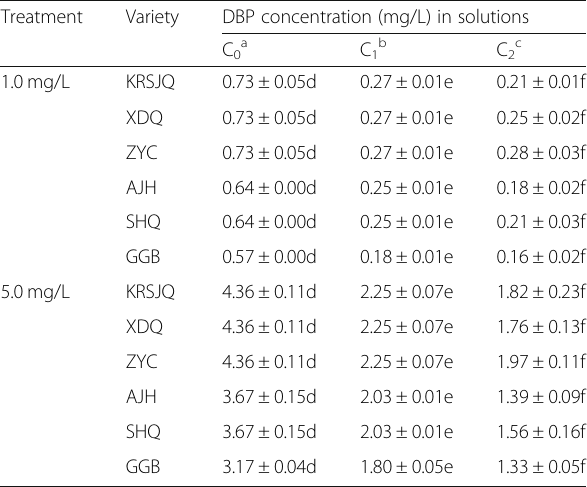
Table 1 DBP concentrations in the nutrient solution for six vegetables (Kangresijiqing (KRSJQ), Xiadiqing (XDQ), Ziyoucai (ZYC), Aijiaohuang (AJH), Shanghaiqing (SHQ) and Gaogengbai (GGB)). Each treatment consisted of five replicates. The values with the different letter(s) were significantly different ( p <